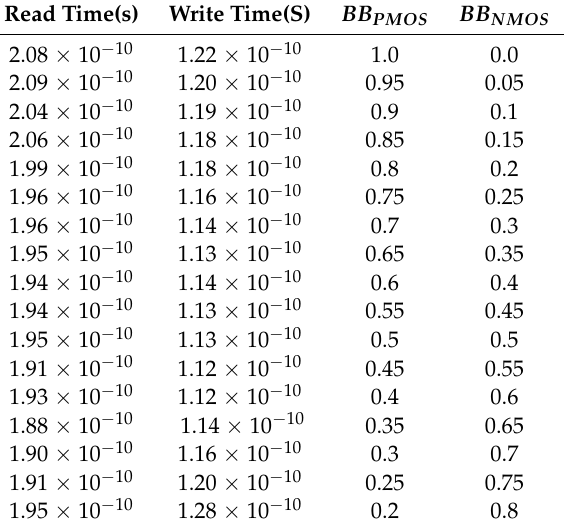
Table 2. Body biasing